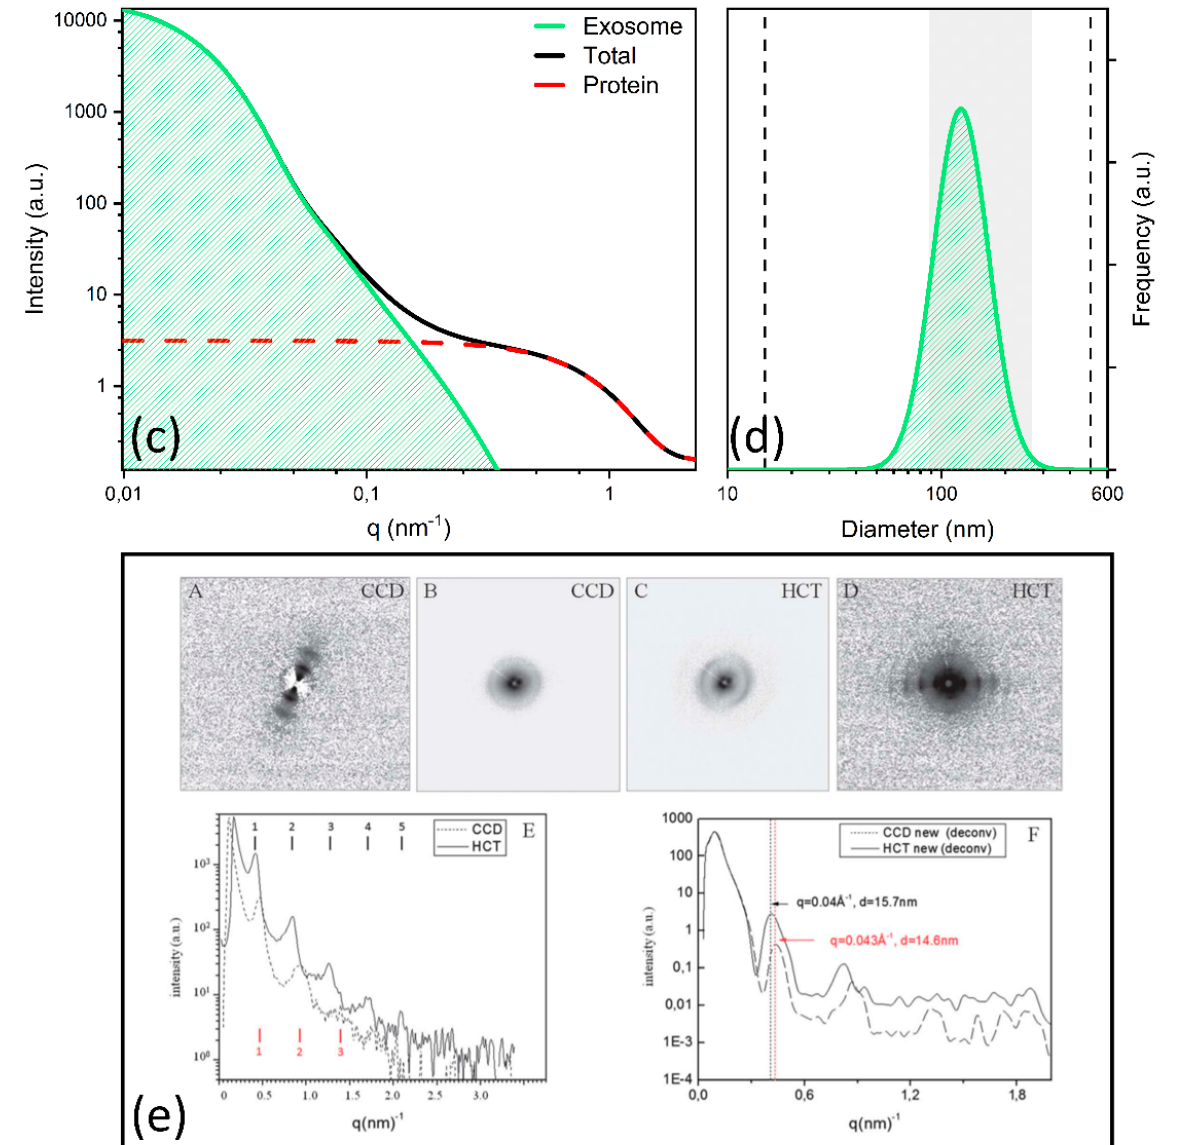
Figure 4. Schematic view of an SAS ( a ) and GISAXS experiment ( b ); simulation of the different contributions to the SAXS pattern measured by Varga et al. [121] on erythrocyte-derived EVs ( c ) with the corresponding distribution function ( d ). SAXS and WAXS profiles measured in [122] on exosomes obtained from healthy and cancer cells, pointing out the potential role of these techniques in exosome-based liquid biopsy. Data are reprinted with permission from ref [122] Copyright Royal Chemical Society, 2013 ( e ).